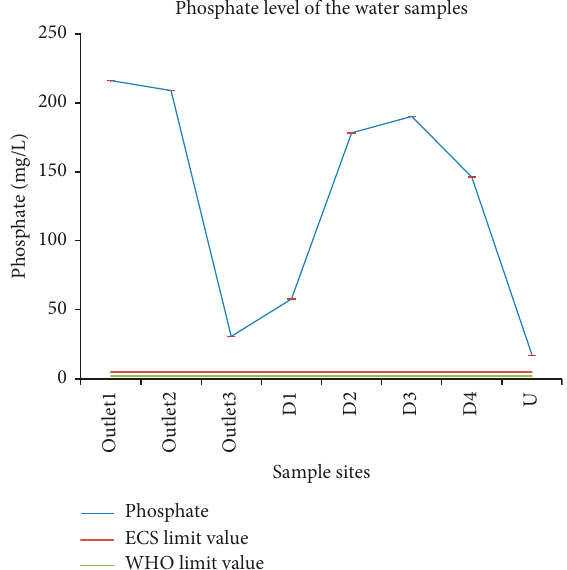
Figure 7: Comparison between phosphate level in wastewater from the Zenzelma campus and the ECS and WHO recommended phosphate discharge limit in